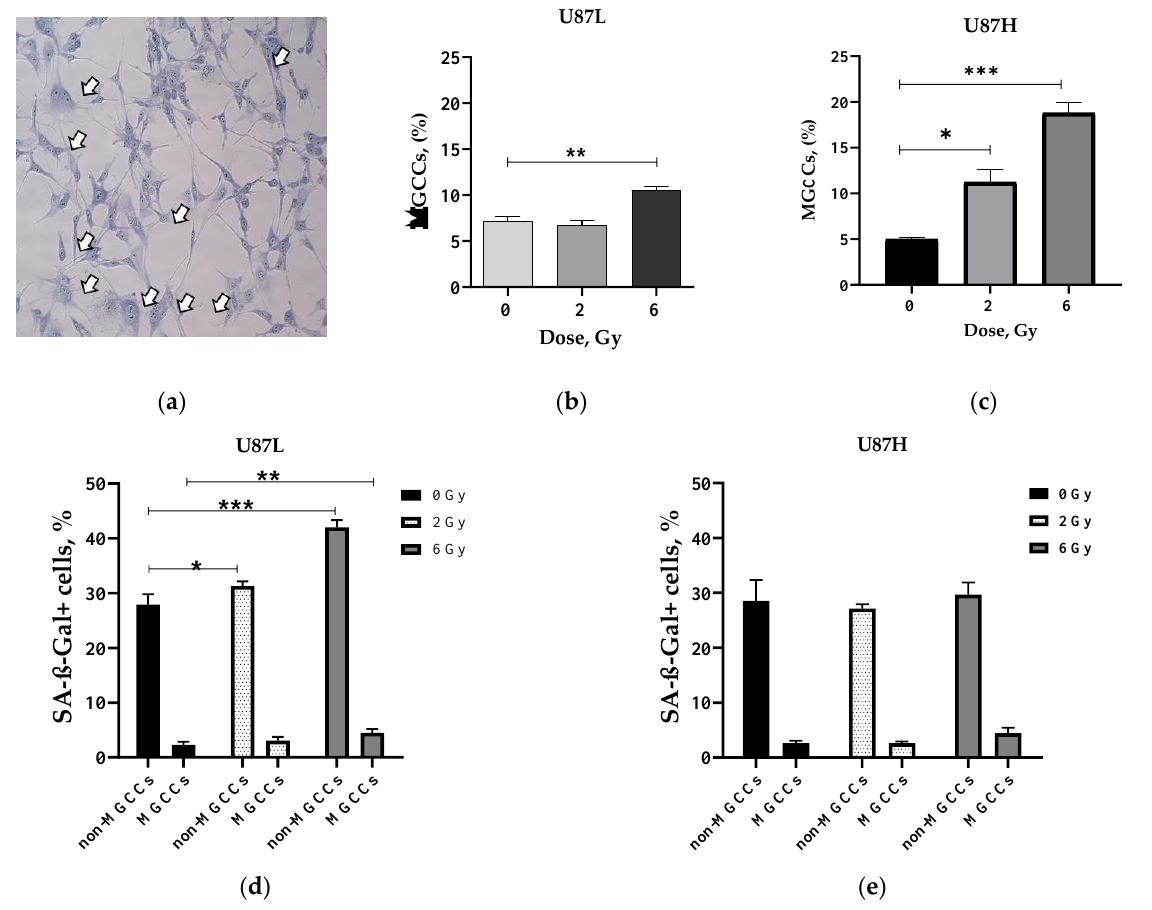
Figure 3. MGCCs formation in minimally-cultured and long-term cultivated GBM upon irradiation. Representative picture of MGCCs (indicated by arrows) ( a ). Change in the proportion (%) of MGCCs in U87L ( b ) and in U87H ( c ) cell lines 24 h after irradiation. Changes in the proportion (%) of SA- β - Gal+ populations in U87L ( d ) and U87H ( e ) cell lines 24 h after exposure to IR at doses of 2 and 6